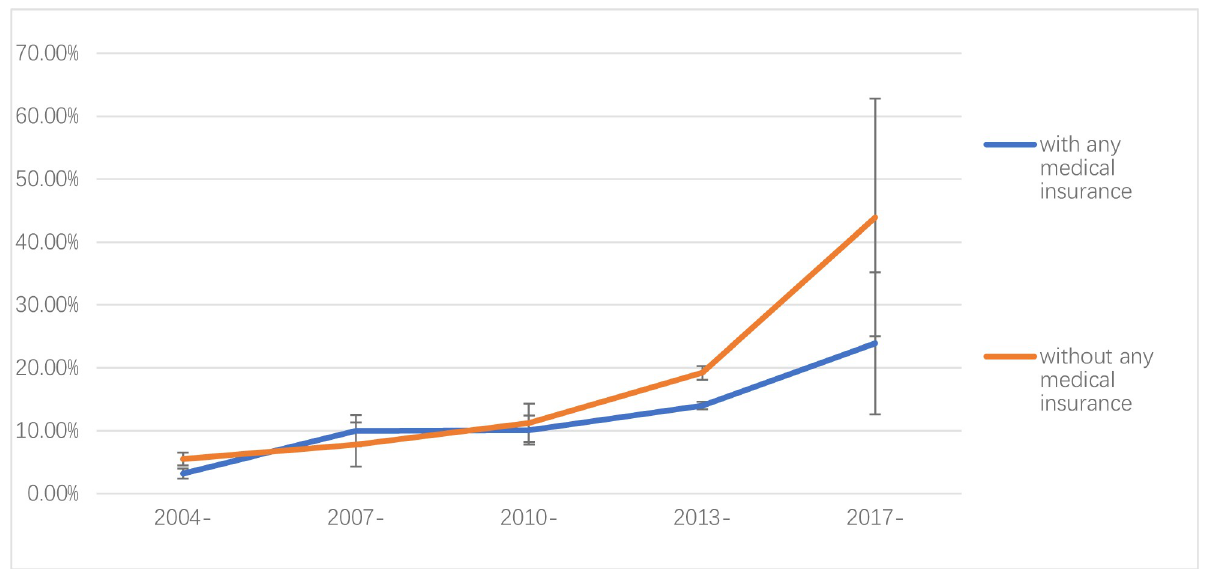
Fig 5. Secular trend of rate of catastrophic health expenditure and health insurance.